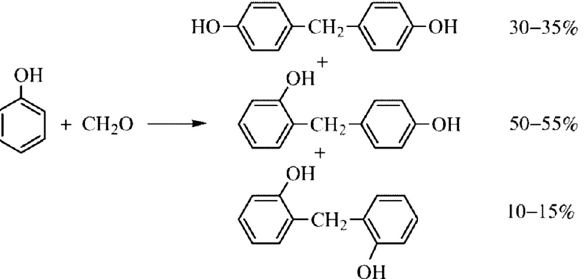
Figure 3: Formation reaction of GPE - 221 from cycloole fi n and peracetic acid [ 24 ]